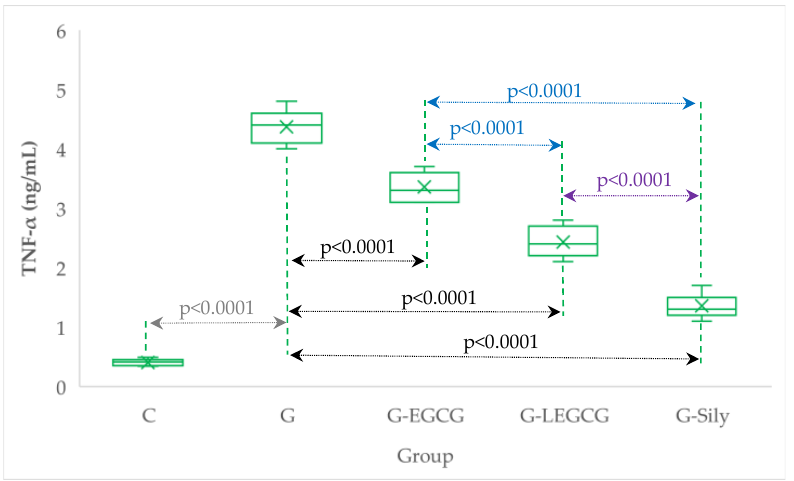
Figure 1. Serum levels of TNF- α by groups . C, control group; G, gentamicin group; G-EGCG, gentamicin and epigallocatechin gallate group; G-LEGCG, gentamicin and liposomal epigallocatechin gallate group; G-Sily, gentamicin and silymarin group.